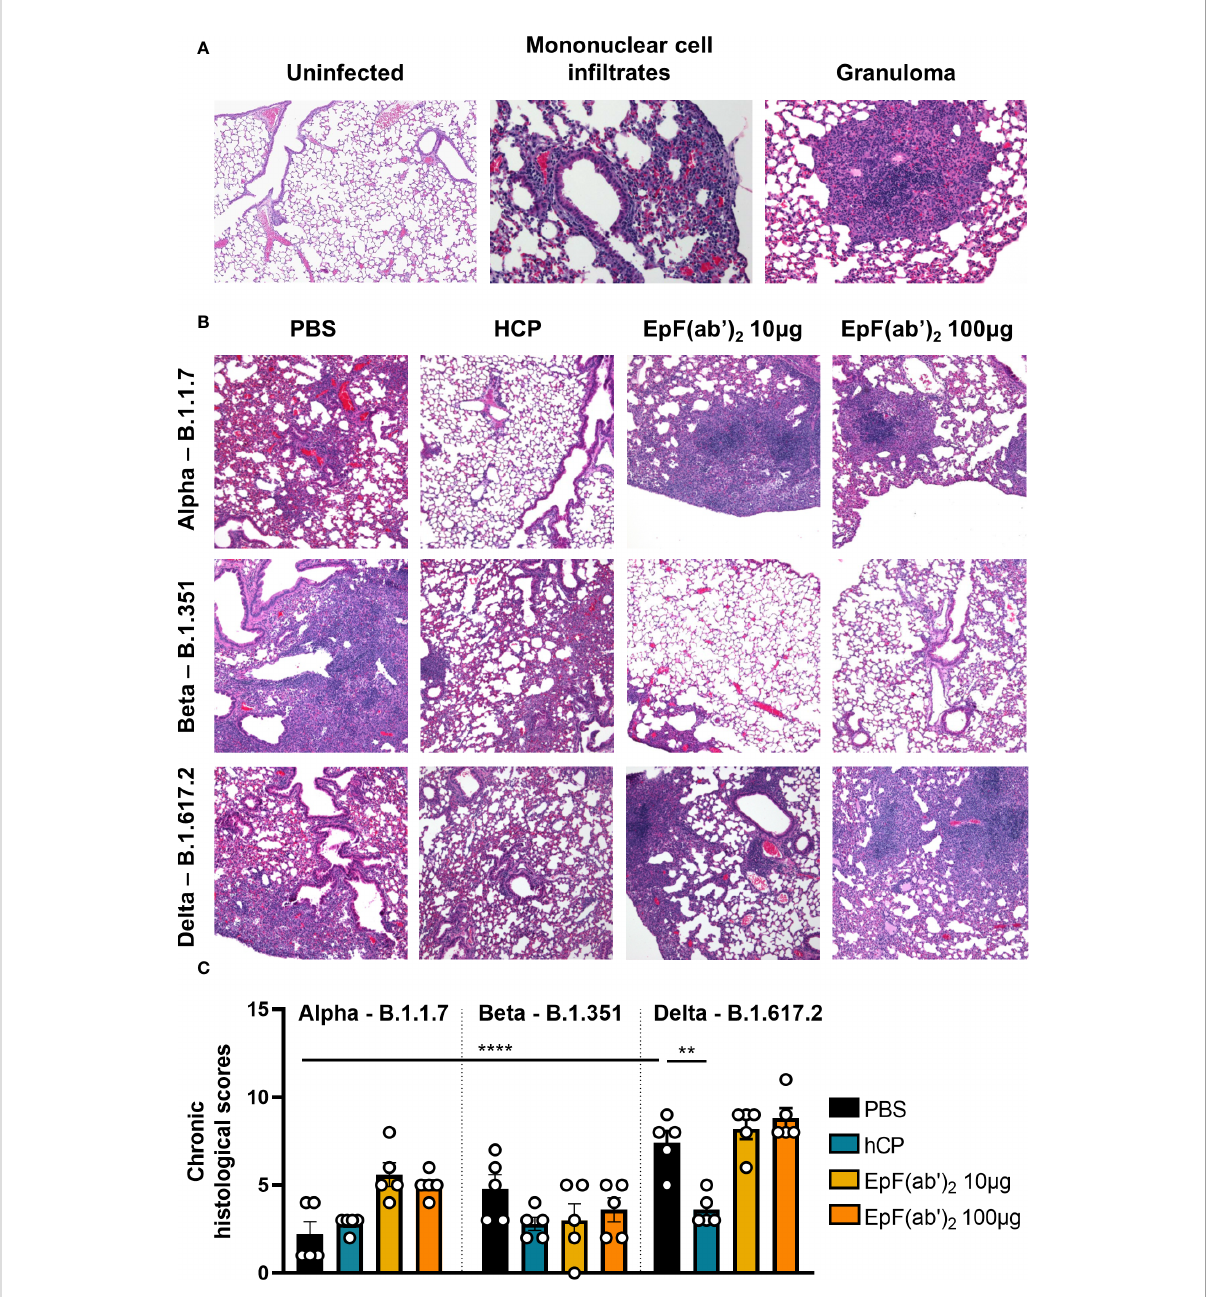
FIGURE 6 SARS-CoV-2 causes chronic in fl ammation in the lung of infected K18-hACE2 mice. (A) Histopathological analysis of hematoxylin-eosin-stained sections of lung from non-infected and SARS-CoV-2 infected K18-hACE2 mice (Representative images at 200x magni fi cation). Left: Characteristic features of a non-infected lung (left); Center: detection of increased numbers of mononuclear cells within the parenchyma (asterisk), surrounding blood vessels (arrowhead), and surrounding bronchi/bronchioles (arrow) in the lung of mice infected with B.1.1.7; Right: Detection of granulomatous in fl ammation in the lung of mice infected with B.1.351. (B) Histopathological analysis of hematoxylin-eosin stained sections of lung from SARS-CoV-2 infected K18-hACE2 mice untreated, or treated with HCP or EpF(ab ’ ) 2 (representative images at 100x magni fi cation). (C) Chronic histological scores from hematoxylin-eosin stained sections of lung from SARS-CoV-2 infected K18-hACE2 mice untreated, or treated with HCP or EpF(ab ’ ) 2 . \Differences between infected groups are denoted with brackets (One-way ANOVA with Tukey ’ s multiple comparison test). ** p < 0.01, and **** p <